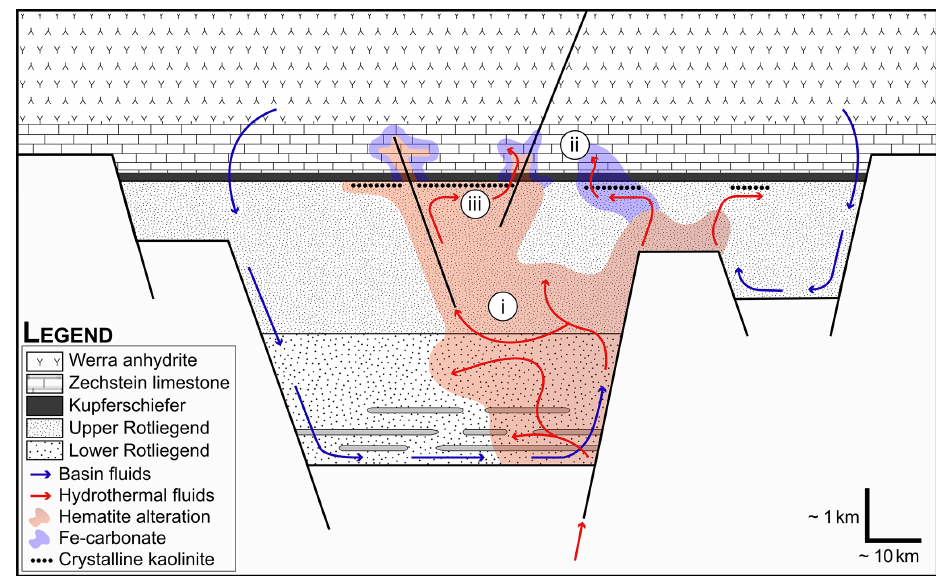
Figure 13. Schematic cross-section through the CESB with fluid migration paths and alterations footprint, i.e. hematite alteration (Rote Fäule), Fe-carbonate alteration, and the occurrence of well-crystallised kaolinite. The distribution and relative intensity of these hydrothermal alteration processes are measurable through HSI indices referred to in this study respectively as (i) Fe 3 + index, (ii) Fe 2 + index, and (iii) KI. Grey layers in the Lower Rotliegend are thick volcanic piles (modified after Borg, 1991, and Borg et al.,